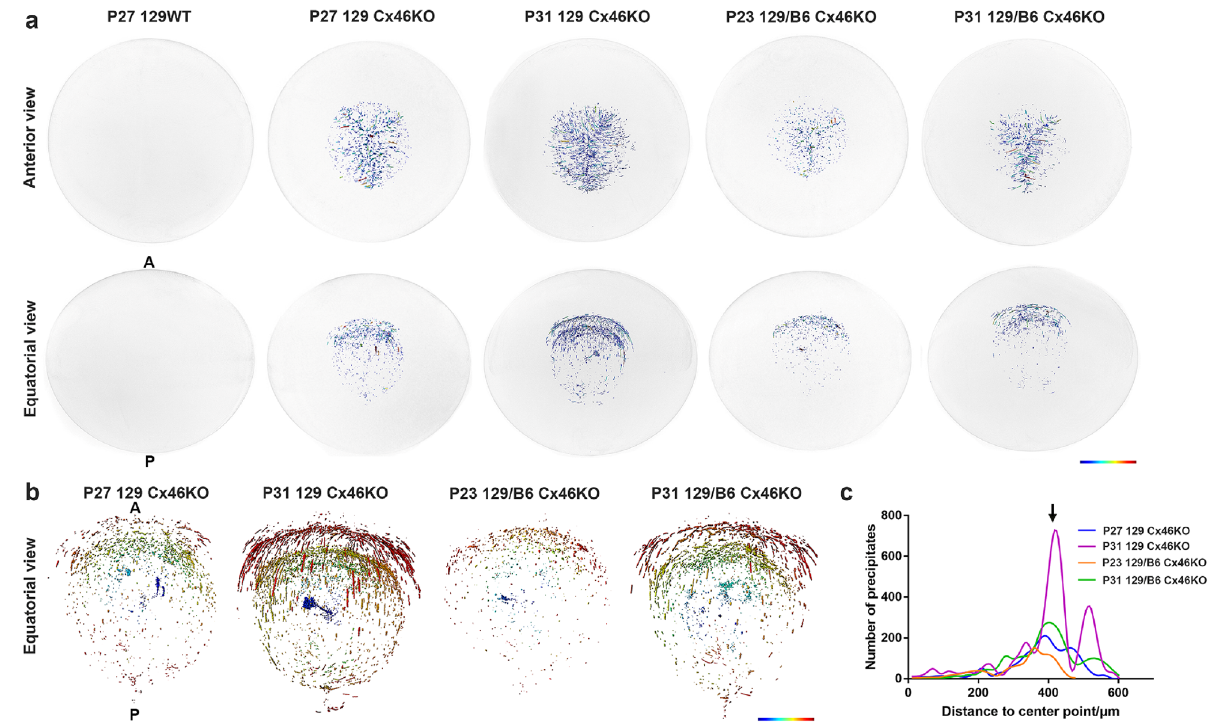
Figure 2. Lens μCT images show the distribution of electron-dense precipitates in Cx46KO lenses. ( a ) 3D visualization of reconstructed μCT images of 129 wild-type, 129 Cx46KO, and 129/B6 Cx46KO lenses, the same lenses shown in Fig. 1. Each individual lens was used for both anterior and equatorial image analysis. Electron- dense precipitates, shown as dark blue dots, were only detected in the cataractous regions of all Cx46KO lenses but not in the wild-type control lens. For the equatorial images, lens anterior (A) and posterior (P) poles were indicated on the left image. ( b ) Enlarged equatorial images were false colored depicting the aggregate distance of individually colored precipitates to the central point of two 129 Cx46KO lenses (P27 and P31) and two 129/ B6 Cx46KO lenses (P23 and P31), magenta/red color representing further away from the center point and blue/ green representing close to the center point. ( c ) Quantitative distribution graph shows the total number of individual precipitates versus their distances to the lens center point for the images in ( b ). The major peak of precipitates (indicated by an arrow) is located at around 400 µm from the lens center point. This peak is higher in P31 129 Cx46KO than in P27 129 Cx46KO, and it is also higher in P31 129/B6 Cx46KO than in the P23 129/ B6 color and the far-away precipitates were shown in magenta/red color (Fig. 2b). Precipitates of P31 129 Cx46KO and P31 129/B6 Cx46KO lenses formed two enriched shell-like layers in the anterior sides of the lens cores while precipitates of P27 129 Cx46KO and P23 129/B6 Cx46KO lenses displayed less obvious shell-like layers. A quantitative analysis of all precipitates versus their distances to the lens centers of four Cx46KO lenses revealed two peaks about 100 µm apart, one located at about 420 µm and the other located at 520 µm distances from the lens center (Fig. 2c). These two peaks correspond to two shell-like layers in the high-magnified equatorial view images of P31 Cx46KO lenses. These results indicated that both the amount and location of these precipitates seemed to be correlated with age-related nuclear cataract of Cx46KO mice at 129 and 129/B6 strain backgrounds. Therefore, we further per- formed high-resolution quantitative analysis of precipitates’ geometrical parameters as well as absorption from these 129 and 129/B6 Cx46KO lenses.